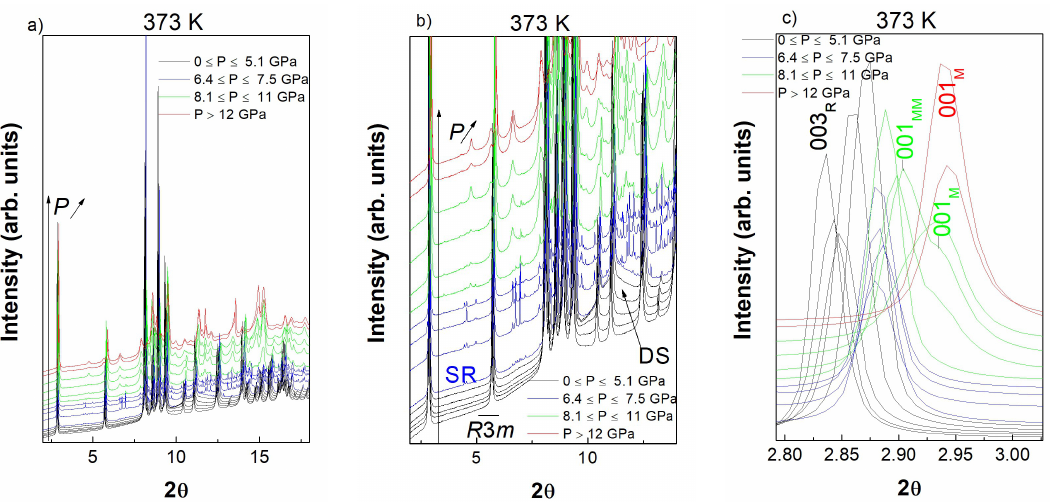
Figure 1. Pressure dependence of the LuFe 2 O 4 X-ray data at 373 K, ( a ) full-2 ϴ -range, ( b ) 2°–14°-2 ϴ -range, ( c ) 2.8°–3.02°-2 ϴ -range. Appearance of superlattice reflections (SR) and diffuse scattering (DS) are indicated.